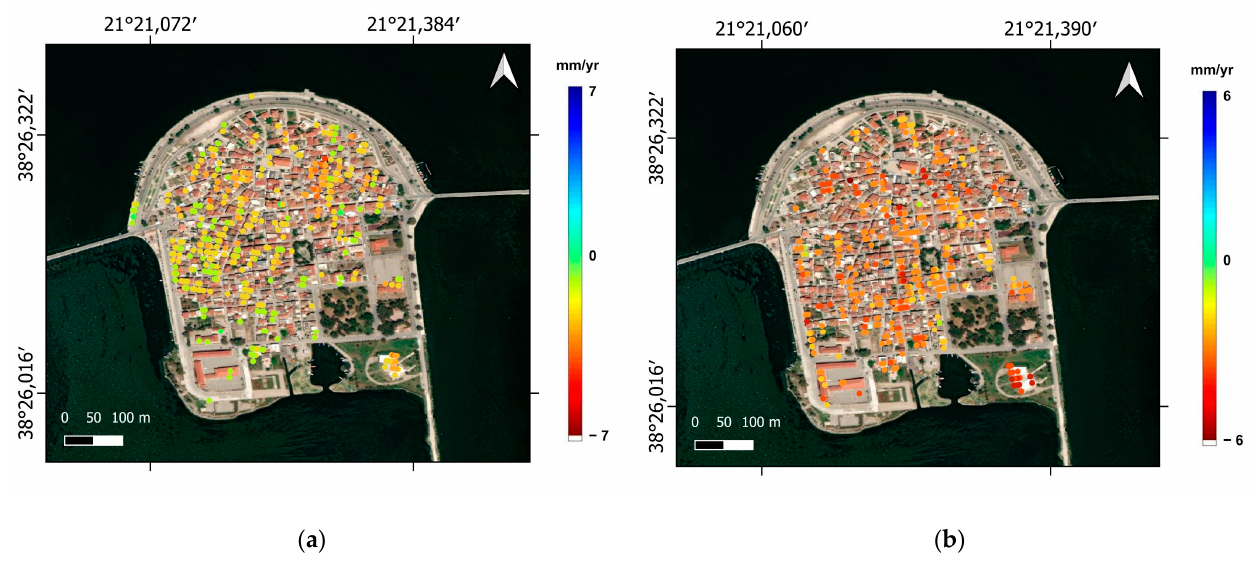
Figure 15. Spatial distribution of the Sentinel-1 vertical deformations in Aitolikon for ( a ) the descending satellite pass (no. 80) & ( b ) the ascending satellite pass (no. 175). Both coming from the P-PSI satellite data analysis conducted at BEYOND.